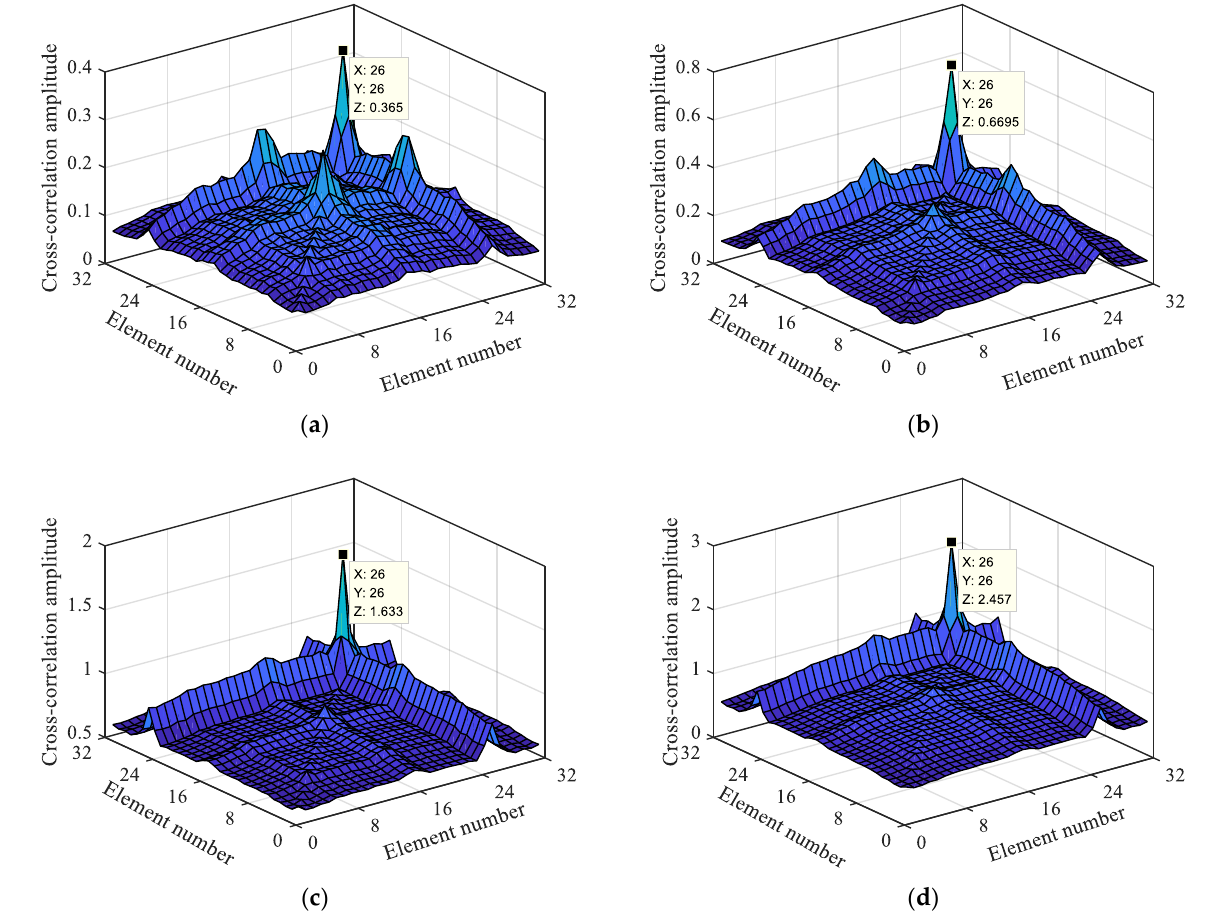
Figure 10. Macro-dynamic strain cross-correlation based on damage level of 2 with different vehicle- to-bridge mass ratio; ( a ) 1.22; ( b ) 1.84; ( c ) 2.45; ( d ) 3.14.